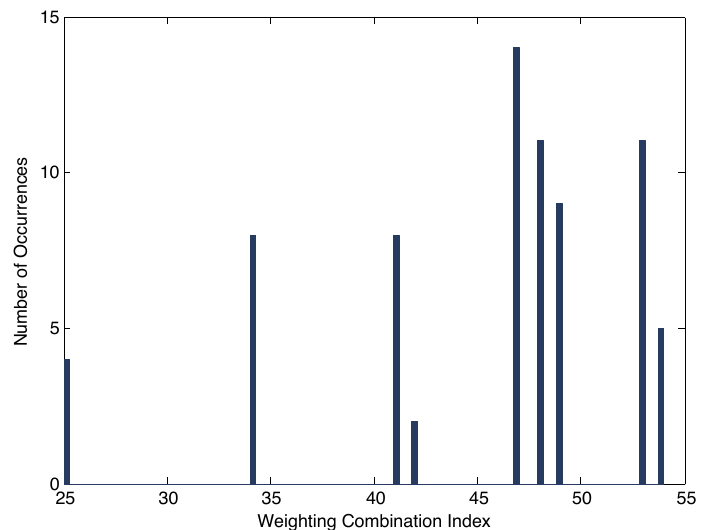
Figure 6. Histogram of solution